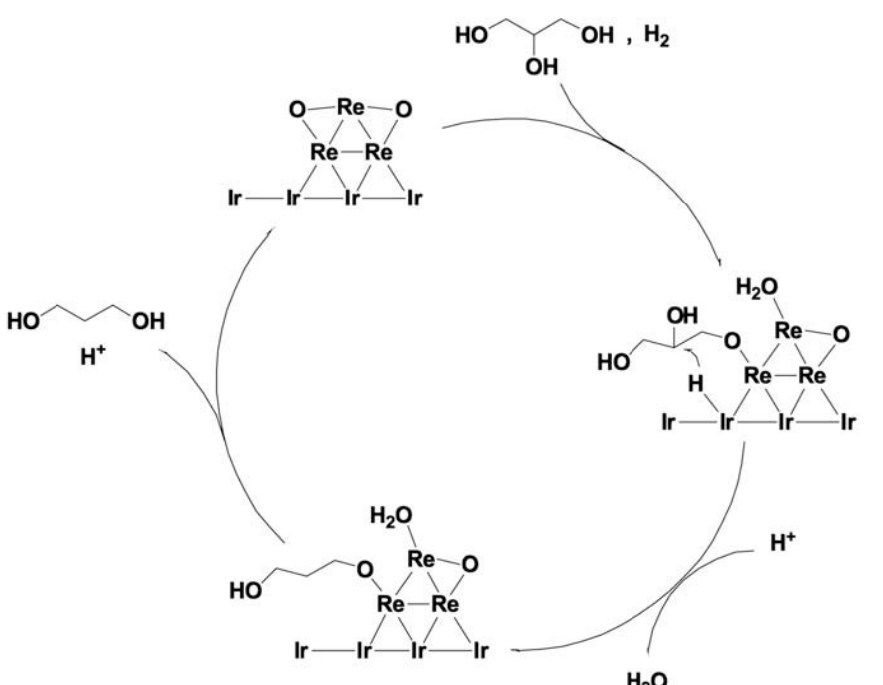
Figure 8. The mechanism for the formation of 1,3-PG in the presence of Ir-ReO x /SiO 2 . Reproduced from [59] with permission from Elsevier.